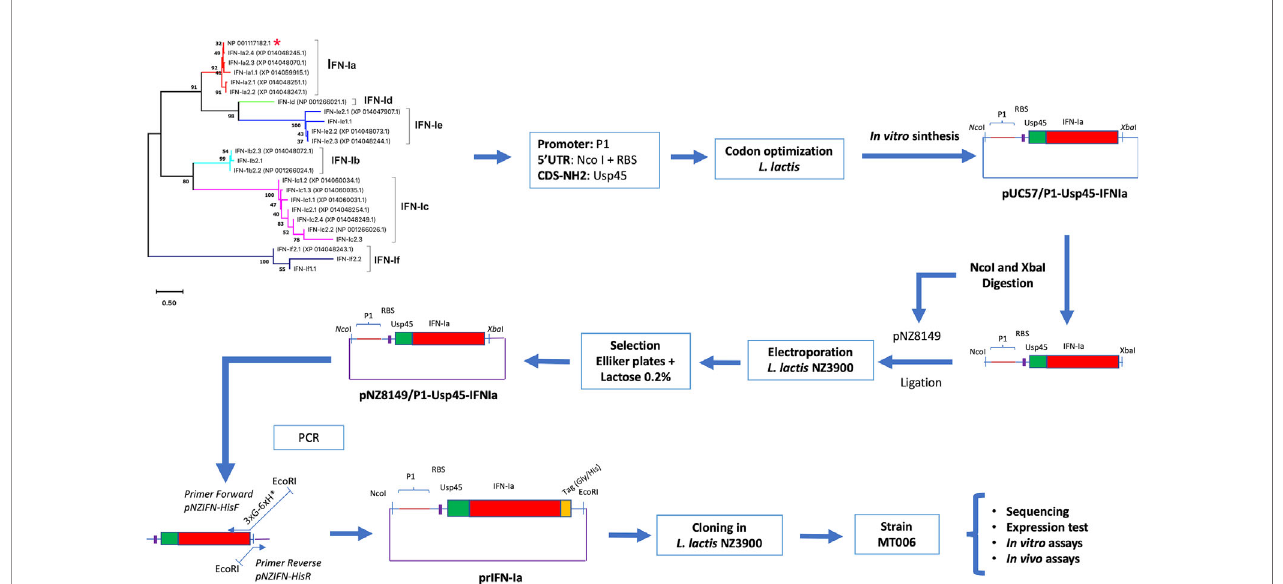
FIGURE 1 | Experimental design to evaluate the use of L. lactis as an oral administration system in Atlantic salmon. The fi gure shows the experimental scheme to evaluate L. lactis as an Interferon oral administration system. The chosen Interferon Ia (red asterisk) was modi fi ed by incorporating a promoter (P1), the signal peptide of the Usp45 protein. The sequence was codogenically optimized and cloned into pUC57 (pUC57/P1-Usp45-IFNIa). This segment was cloned in pNZ8149, electroporated in L. lactis NZ3900 and selected on Elliker medium supplemented with 0.2% lactose. A tag (Gly/His) was added to the terminal COOH end of Interferon Ia by reverse PCR. The plasmid generated prIFN-Ia was cloned in L. lactis NZ3900 giving rise to the strain MT006. The recombinant constructs were sequenced and the functionality of rIFN-Ia was analyzed in vitro and in vivo